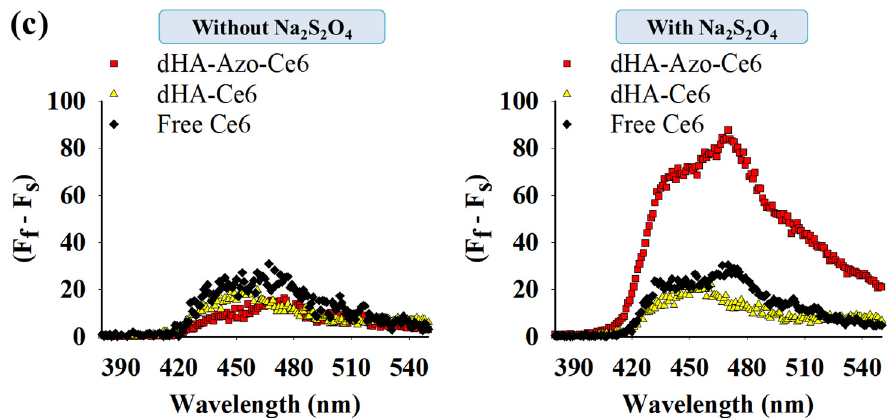
Figure 3. ( a ) Cumulative Ce6 release from dHA-Azo-Ce6 and dHA-Ce6 with or without azo- reductase (Na 2 S 2 O 4 ) treatment (n = 3, as multiple experiments). ( b ) The emission spectra (at λ ex of 400 nm and λ em of 600–720 nm) of each sample (equivalent Ce6 10 μ g/mL) and free Ce6 (10 μ g/mL) in PBS (pH 7.4, 150 mM) with or without azo-reductase (Na 2 S 2 O 4 ) treatment. ( c ) 9,10- dimethylanthracene (DMA) fluorescence change (at λ ex 360 nm and λ em 380–550 nm) of each sample (equivalent Ce6 10 μ g/mL) and free Ce6 (10 μ g/mL) in PBS (pH 7.4, 150 mM) with or without azo- reductase (Na 2 S 2 O 4 ) treatment.